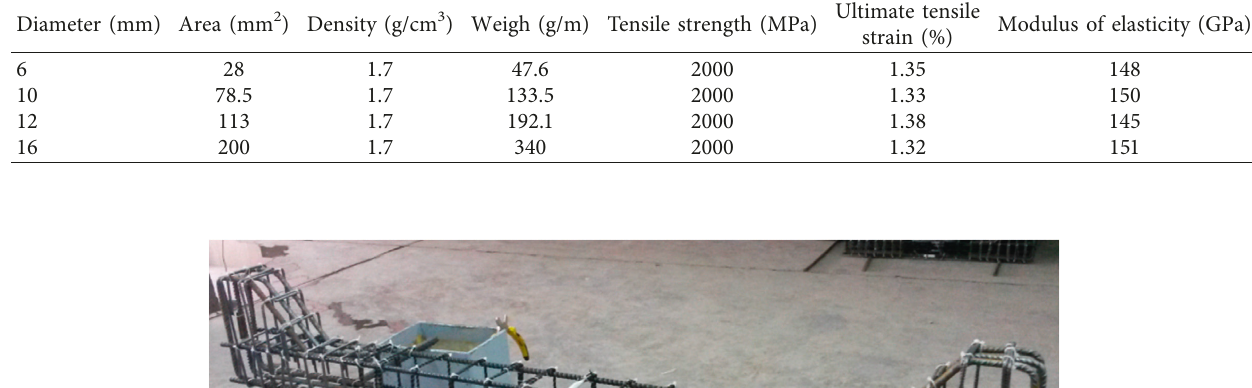
Figure 1: Details of reinforcement of the tested specimens (dimensions are in mm). Table 2: Mechanical properties of CFRP bars.